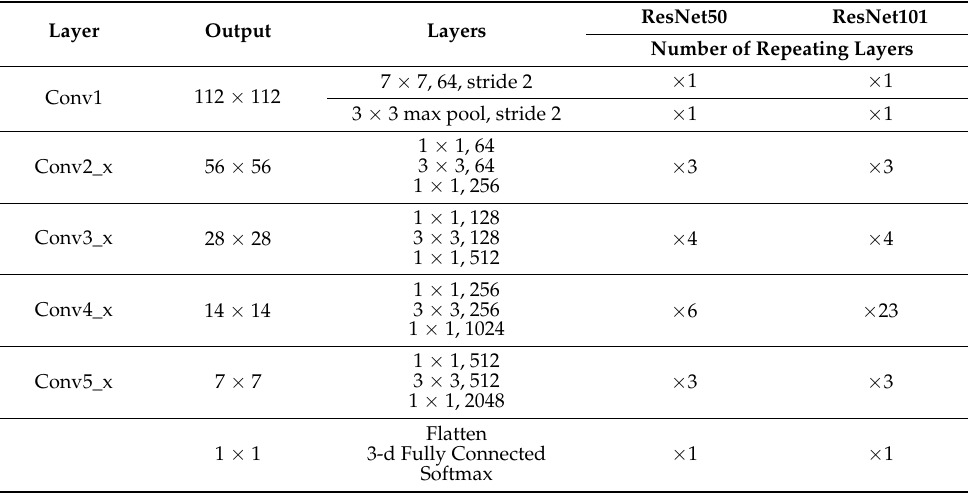
Figure 5. The Xception architecture; first, the data propagate through entry flow (first box), then through middle flow (second box) and repeats eight times. In the end, data propagate through the third box which represents exit flow [44]. Table 3. ResNet50 and ResNet101 architecture